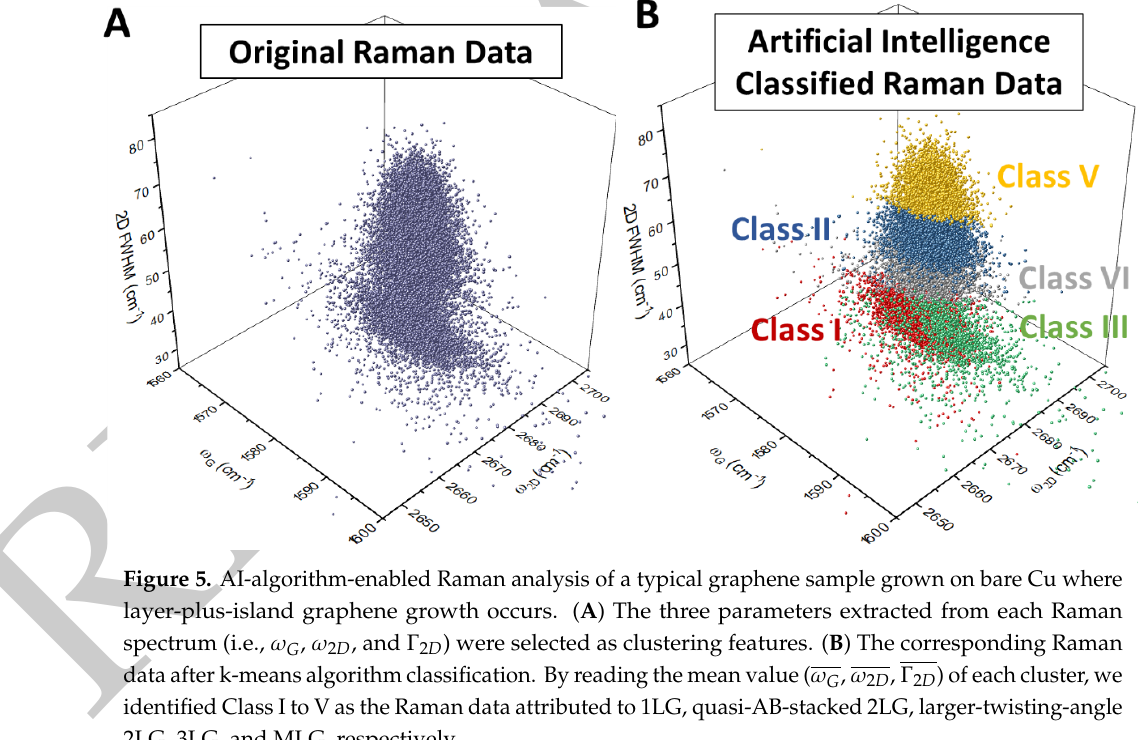
Figure 4. AI-algorithm-enabled Raman analysis of a typical graphene sample grown on treated Cu, where layer-by-layer graphene growth occurs. ( A ) The three parameters extracted from each Raman spectrum (i.e., ω G , ω 2 D , and Γ 2 D ) were selected as clustering features. ( B ) The corresponding Raman data after k-means algorithm classification. A total of 18,000 Raman spectra were clustered into two classes only. By reading the mean value ( ω G , ω 2 D , Γ 2 D ) of each class, we identified Class I and II as the Raman data attributed to 1LG and quasi-AB-stacked 2LG, respectively.